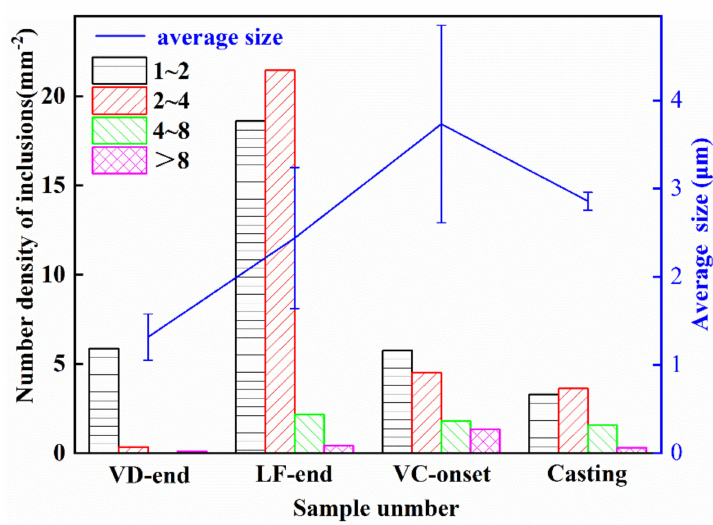
Figure 4. Density and average size of oxides in the steel